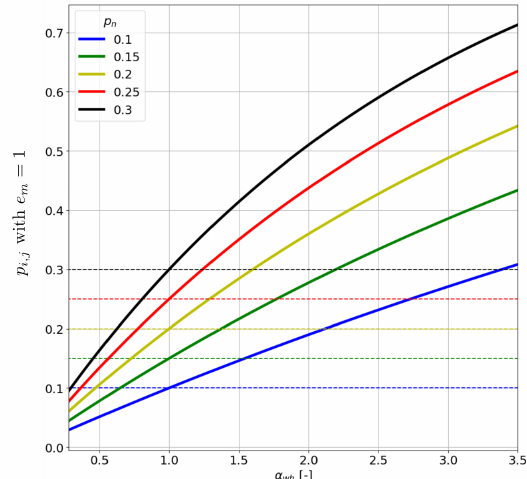
Figure 8. Influence of the combined slope-wind factor on the Fire Spread Probability. The plot portrays the dependence of p ij of Formula (1) on the slope-wind factor α wh , given a fixed e m = 1 and several values for p n .